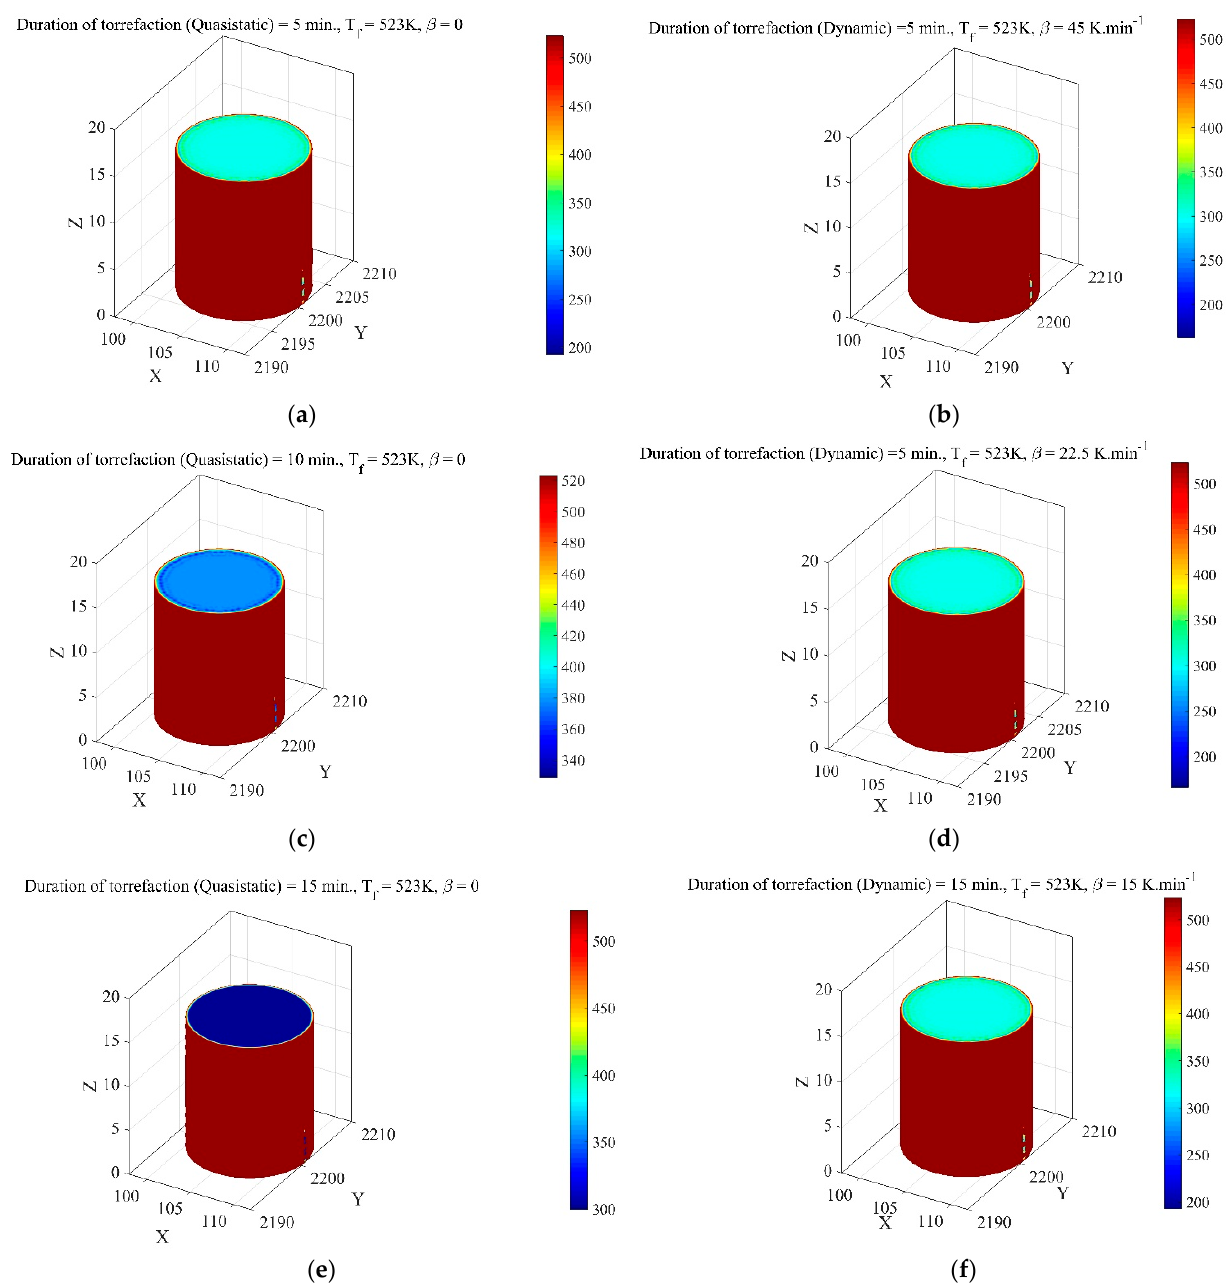
Figure 10. Temperature distribution on the surface of a biofuel pellet in varying heat flux conditions ( a , c , e ): quasi-static, ( b , d , f ): dynamic.